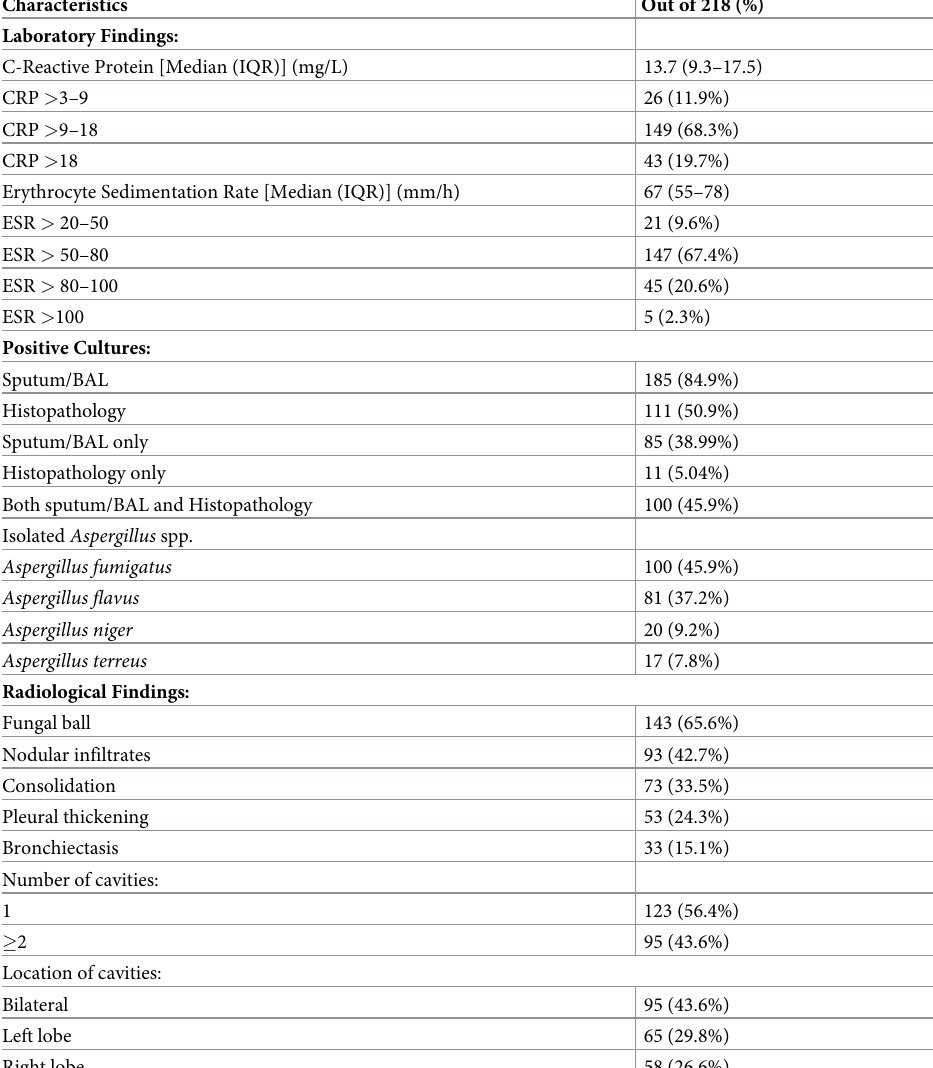
Table 2. Laboratory, microbiological and radiological